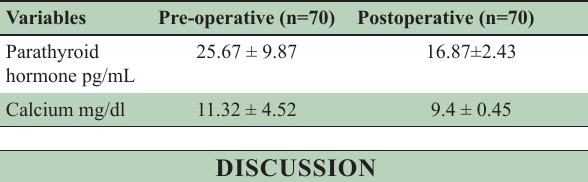
Table-II: Pre-operative and postoperative levels of serum of PTH and